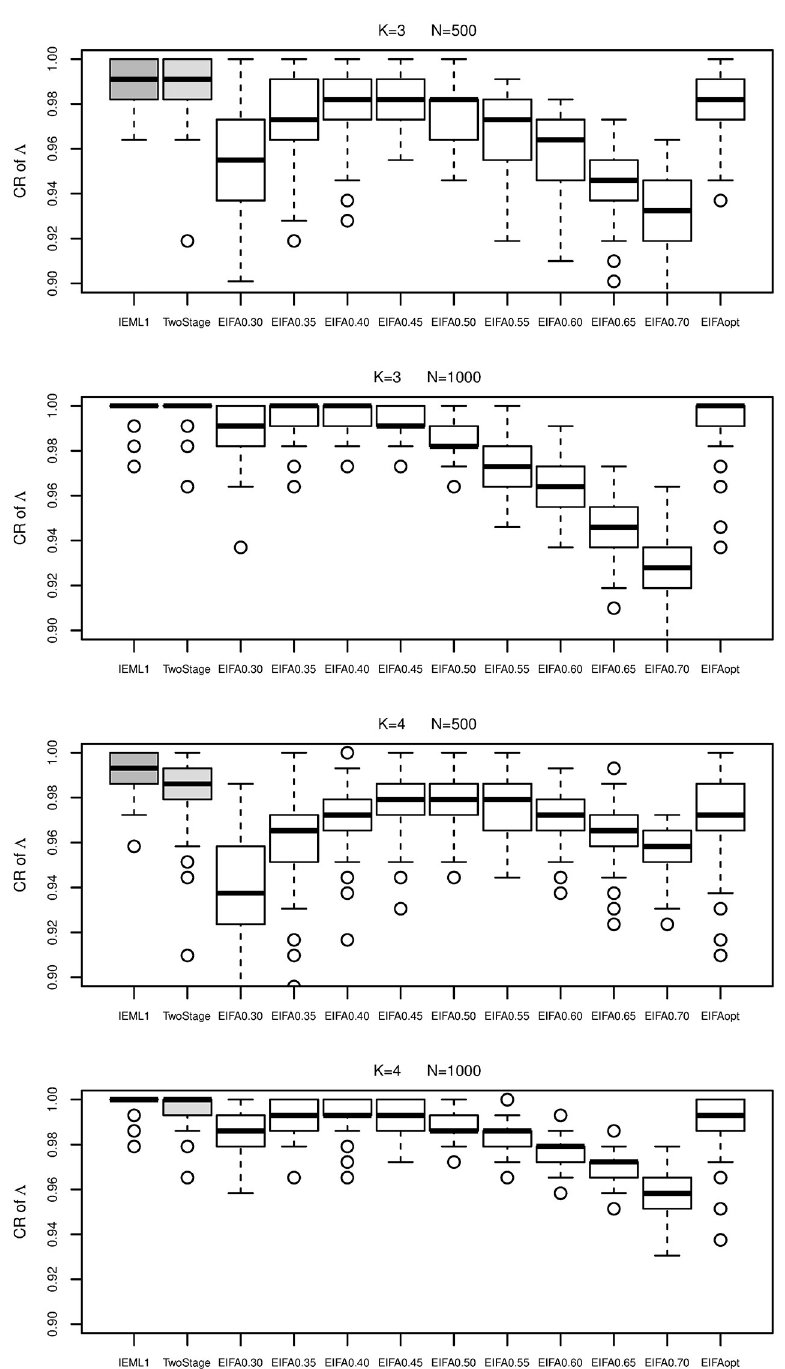
Fig 3. Boxplots of the correct rate of Λ obtained by IEML1 (dark gray boxes), two-stage (light gray boxes), EIFAthr and EIFAopt (white boxes) for K = 3 and 4 under sample size N = 500 and 1000.